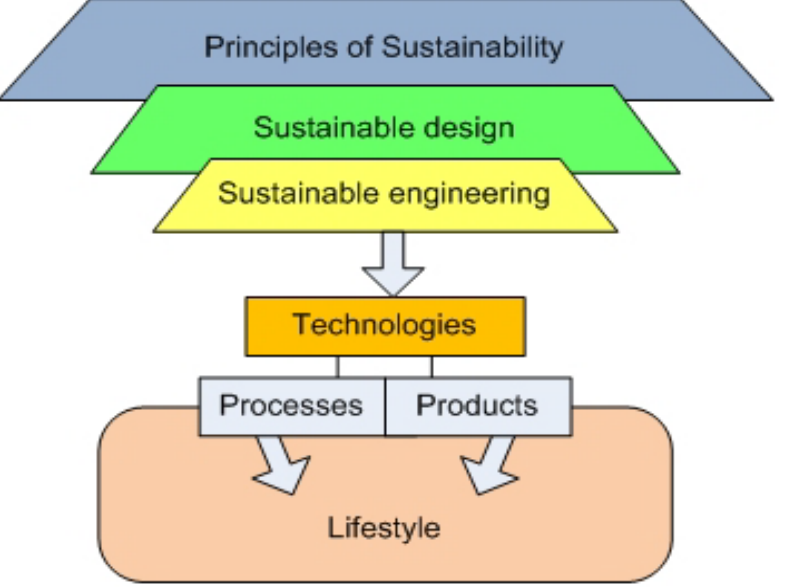
Figure 1. Hierarchy of sustainability principles, technologies, processes, and products is determining humanity lifestyles [23].